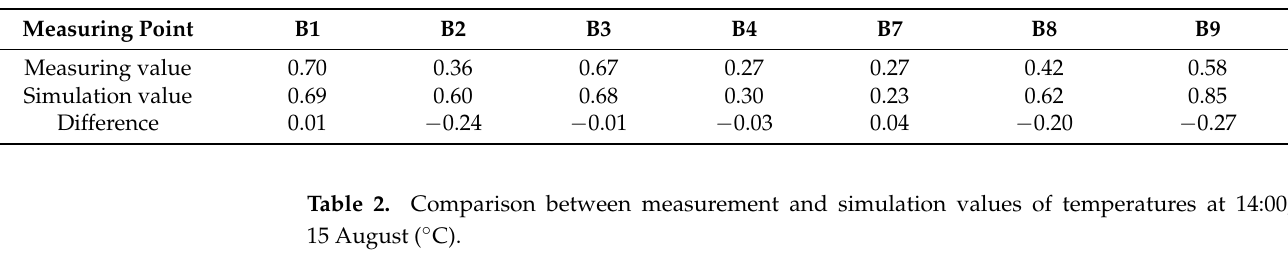
Figure 4. Simulation results at the height of 1.5 m above the ground (14:00, 15 August). ( a ) Velocity distribution. ( b ) Temperature distribution. Table 1. Comparison between measurement and simulation values of velocities at 14:00, 15 August (m/s).